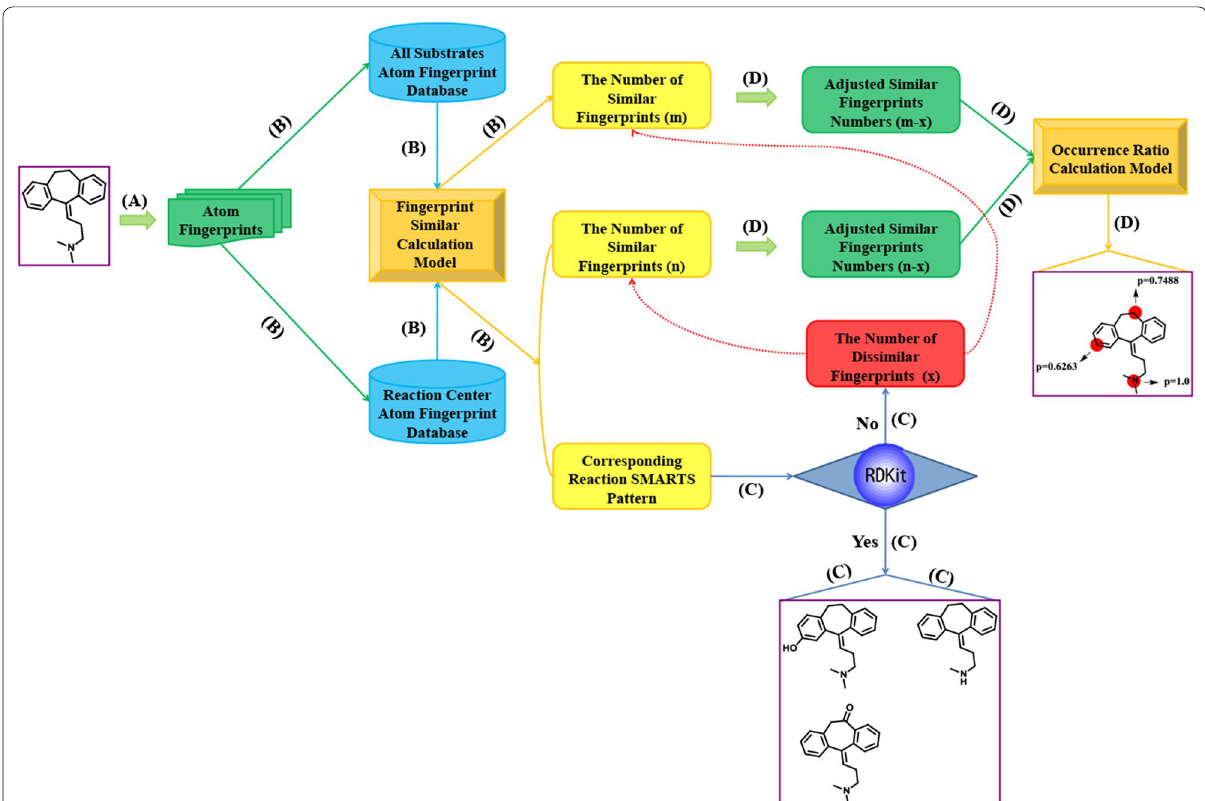
Fig. 1 Schematic representation of RD-Metabolizer workflow for SOMs and metabolites prediction. (A) Convert query compound to topologi- cal atom fingerprints; (B) search the two fingerprint databases by 2D fingerprint similarity calculation model, thus respectively get the number of similar fingerprints from two databases and the corresponding reaction SMARTS patterns from the reaction center topological atom fingerprint database; (C) check if RDKit can act on the reaction SMARTS patterns, then count the number of dissimilar fingerprint and generate corresponding metabolite structures of each site; (D) adjust the number of similar fingerprints and calculate occurrence ratio of each